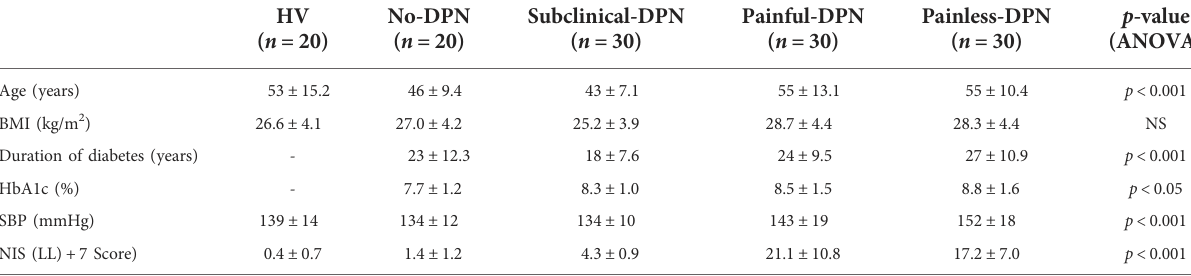
TABLE 1 Demographic, clinical and neurophysiological characteristics of study participants.